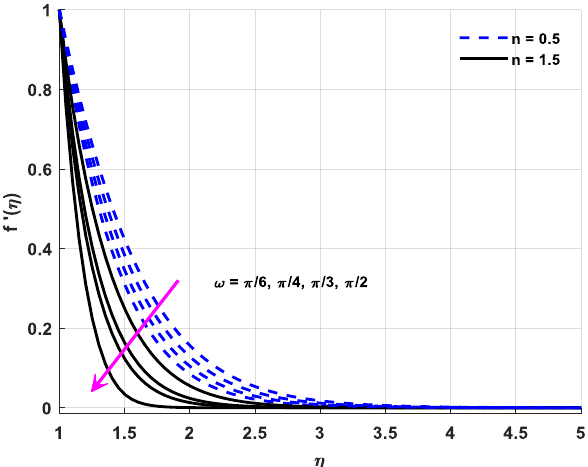
Figure 4. Fluid velocity profile variations owing to changes in ω .